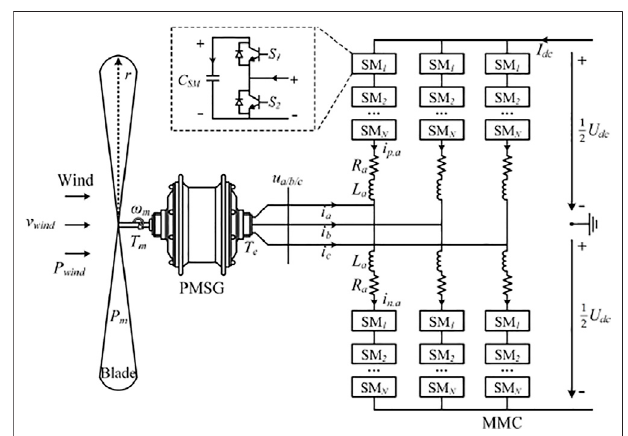
FIGURE 1 | Diagram of the MMC-based wind energy conversion